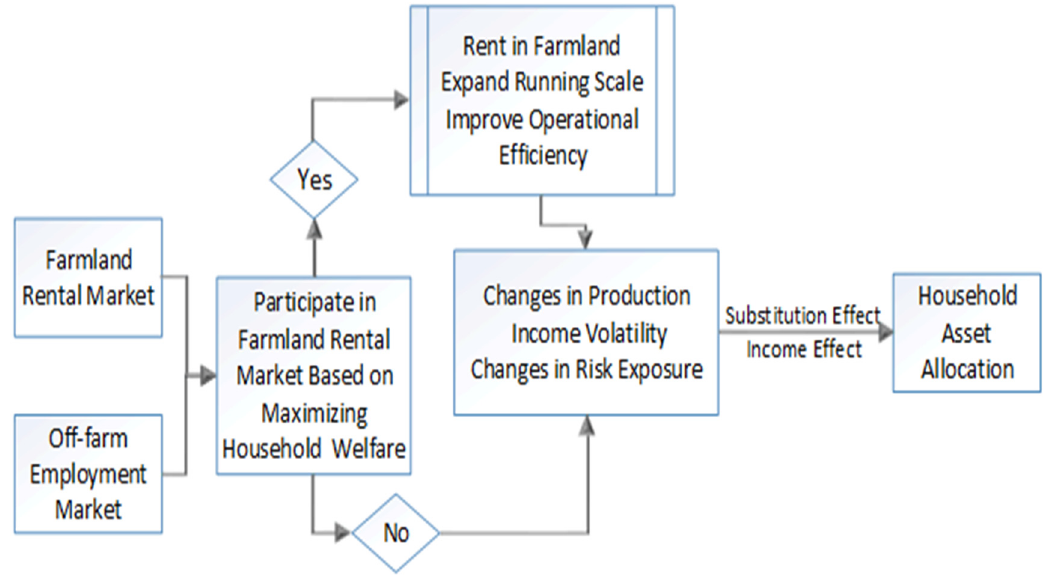
Figure 3. Mechanism of farmland rental market participation affecting household asset allocation